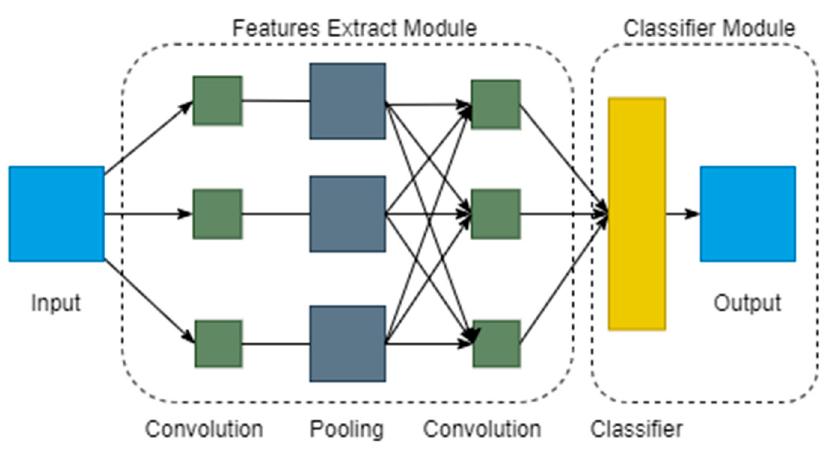
Figure 3. The modules of a basic CNN.